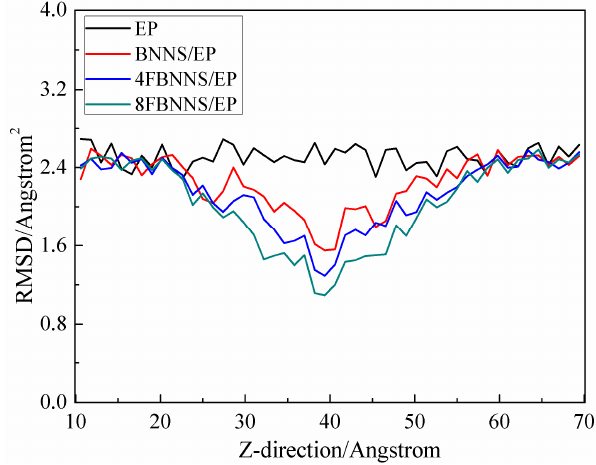
Figure 10. Radial mean square displacement (RMSD) of BNNS/EP nanocomposites.